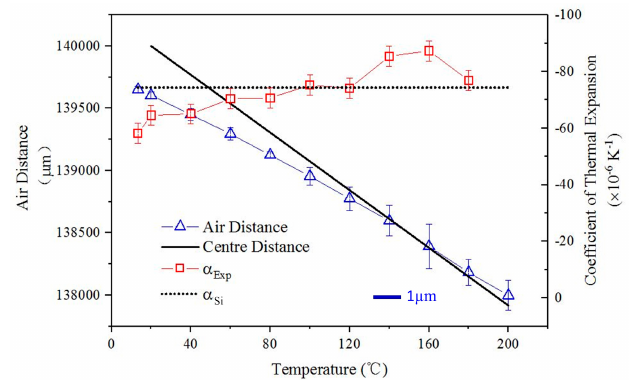
Figure 10. Thermal deformation measurement results of the X-symmetric ITL array. The air distance is the distance between the two lenses fixed on the sample. The center distance is the distance between the long rods on the first and third X-symmetric ITL in the simulation. The blue scale bar represents 1 µm in length of the measurement error of the air distance. The simulation CTE prediction is shown as a dotted line, while the experimental result is the solid line.